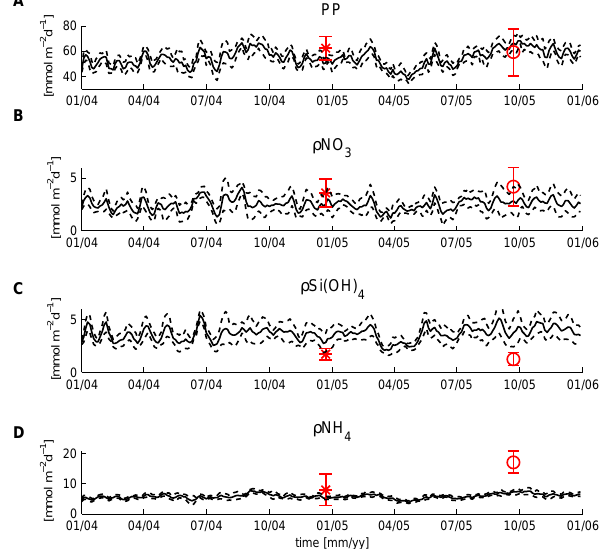
Fig. 4. Model time series of carbon and nutrient uptake rates in the EEP during 2004–2005. Results are depth-integrated and area- averaged. Solid lines are the box means and dashed lines are 1 σ around the mean. Cruise data are from December 2004 (*) and September 2005 (o). The length of red horizontal lines on top and bottom of cruise estimates indicates the length of equatorial tran- sects in days, while the length of vertical red lines around cruise estimates corresponds to 1 σ around the cruise EEP mean. (A) PP (mmolCm − 2 d − 1 ), (B) ρ NO 3 (mmolNm − 2 d − 1 ), (C) ρ Si(OH) 4 (mmolSim − 2 d − 1 ), and (D) ρ NH 4 (mmolNm − 2 d − 1